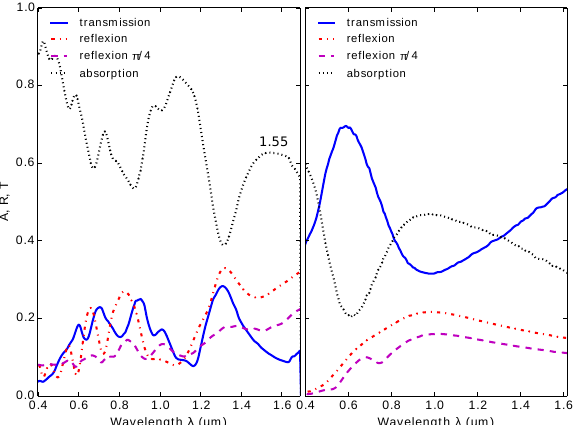
Figure 2: Experiments. Transmission (T, blue solid line), reflection (R, red dashed-dotted line) and absorption (A, black dotted line) spectra of the HPPS (left, the absorption maxima are at 1.1 µ m and 1.55 µ m ) and NPA (right, absorption maximum at 1 µ m ) measured at normal incidence. The magenta dashed lines are the reflection spectra taken at an incidence angle θ = π /4 with respect to the sample’s normal.